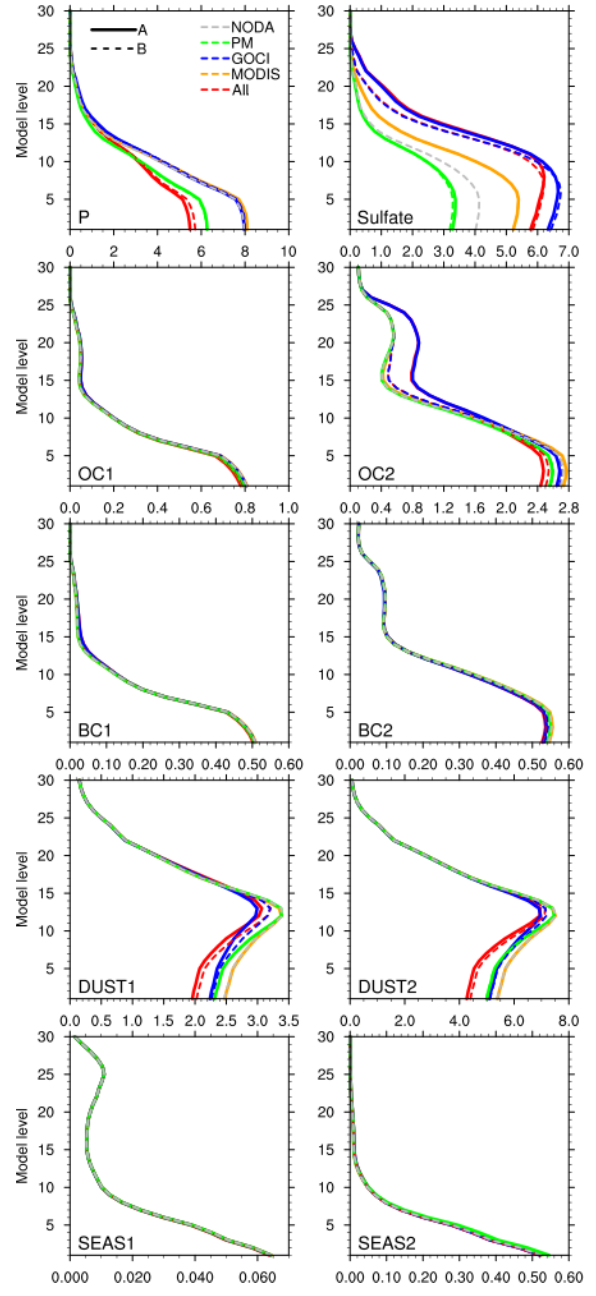
Figure 7. Vertical profile of 10 GOCART aerosol variables com- posed of PM 2 . 5 – unspeciated aerosol contributions to PM 2 . 5 (P), sulfate, OC1 and OC2 (BC1 and BC2) as hydrophobic and hy- drophilic organic (black) carbon, respectively, and DUST1 and DUST2 (SEAS1 and SEAS2) as dust (sea salt) aerosols in the small- est and second-smallest size bins. All the variables shown are mix- ing ratios (µgkg − 1 ). Different experiments are depicted in different colors, as averaged over domain 2 for the period of 4–31 May 2016. The analysis (A) is drawn as a solid line, while the background (e.g., 6h forecast; B) is drawn as a dashed line.